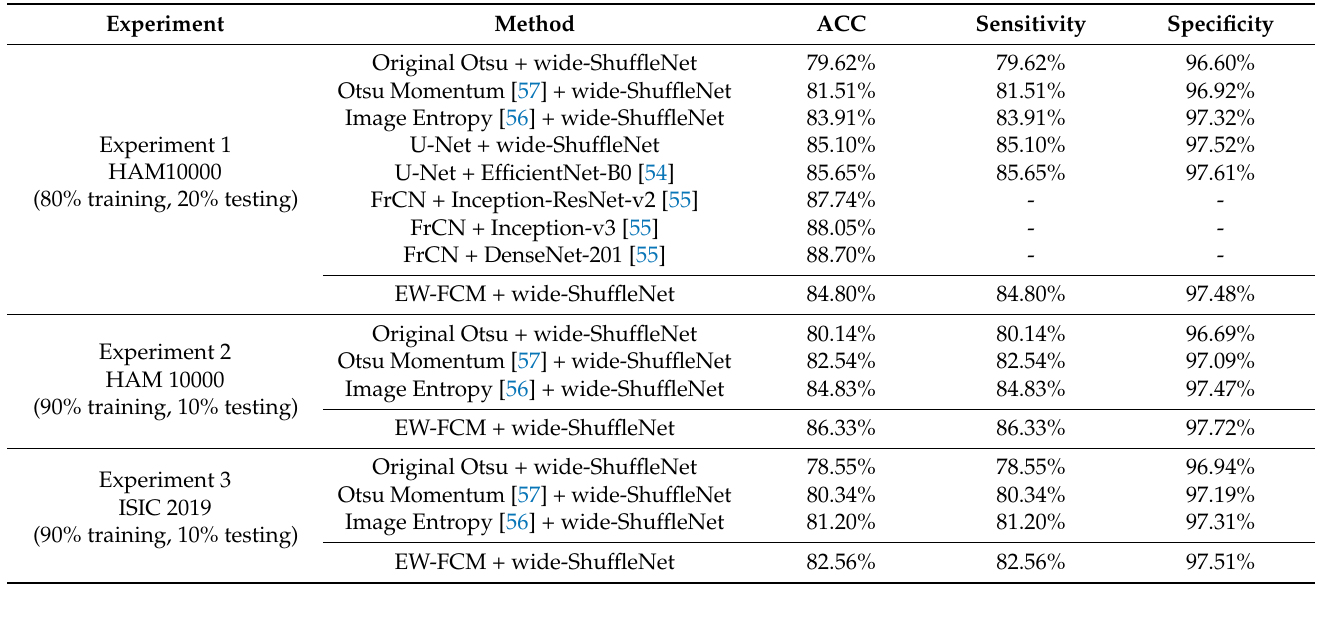
Table 7. Comparison with segmentation methods on the HAM10000 and ISIC2019 datasets (micro-average).